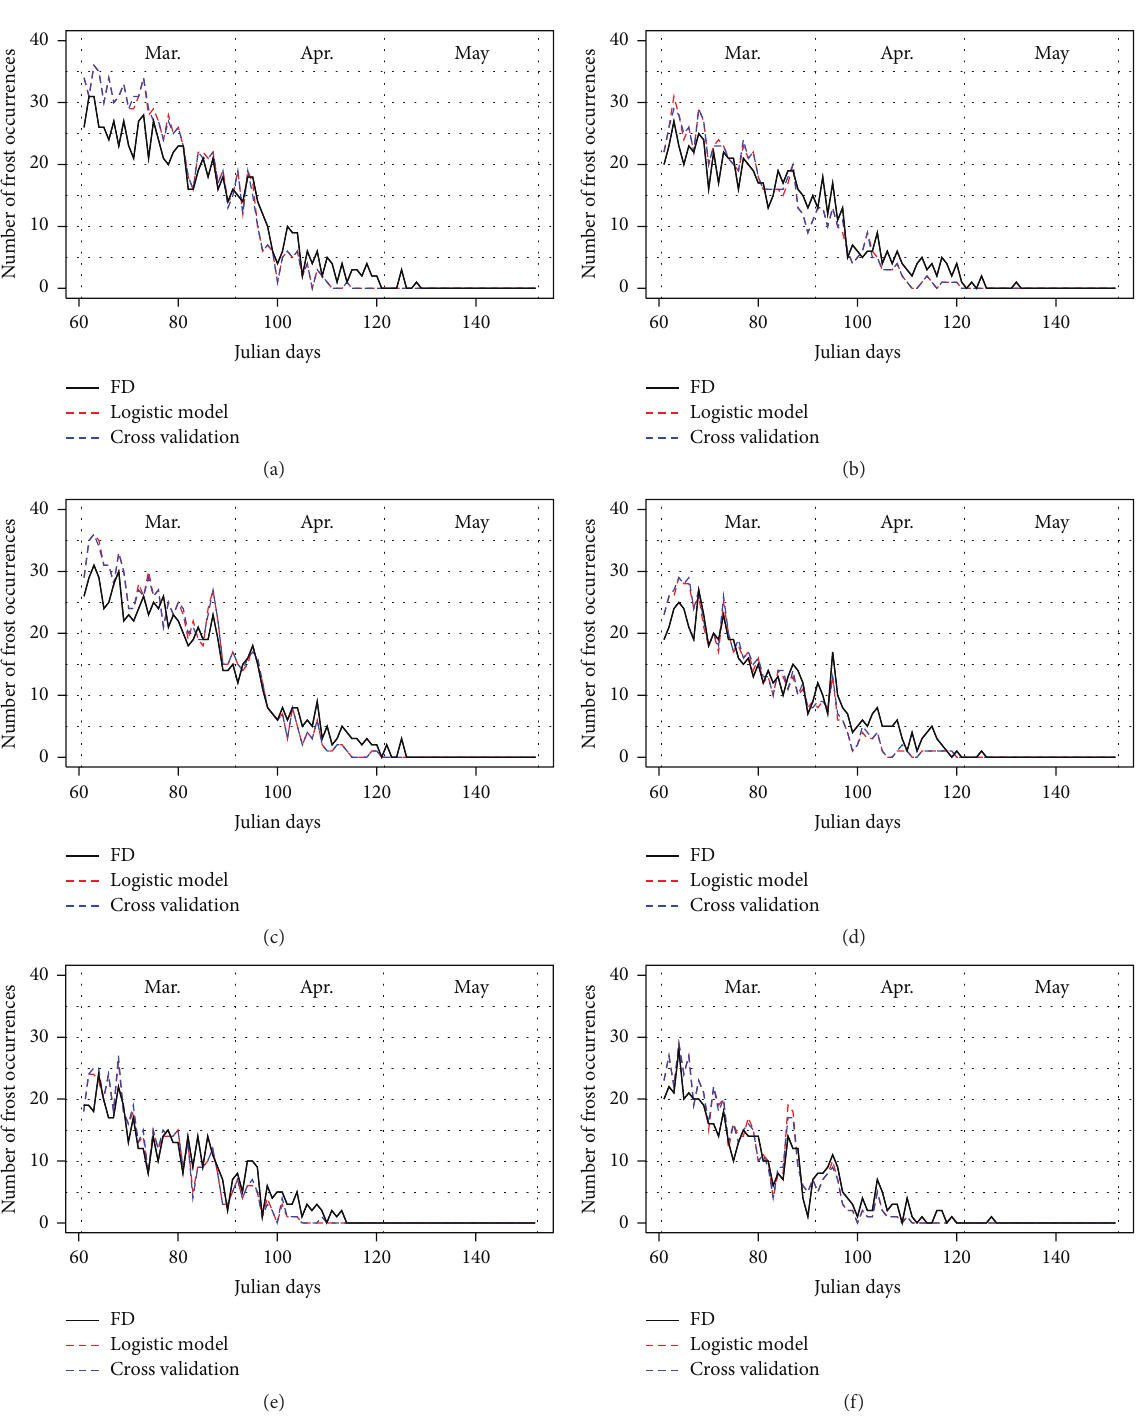
followed by GMINT (four stations) and TMIN (three sta-